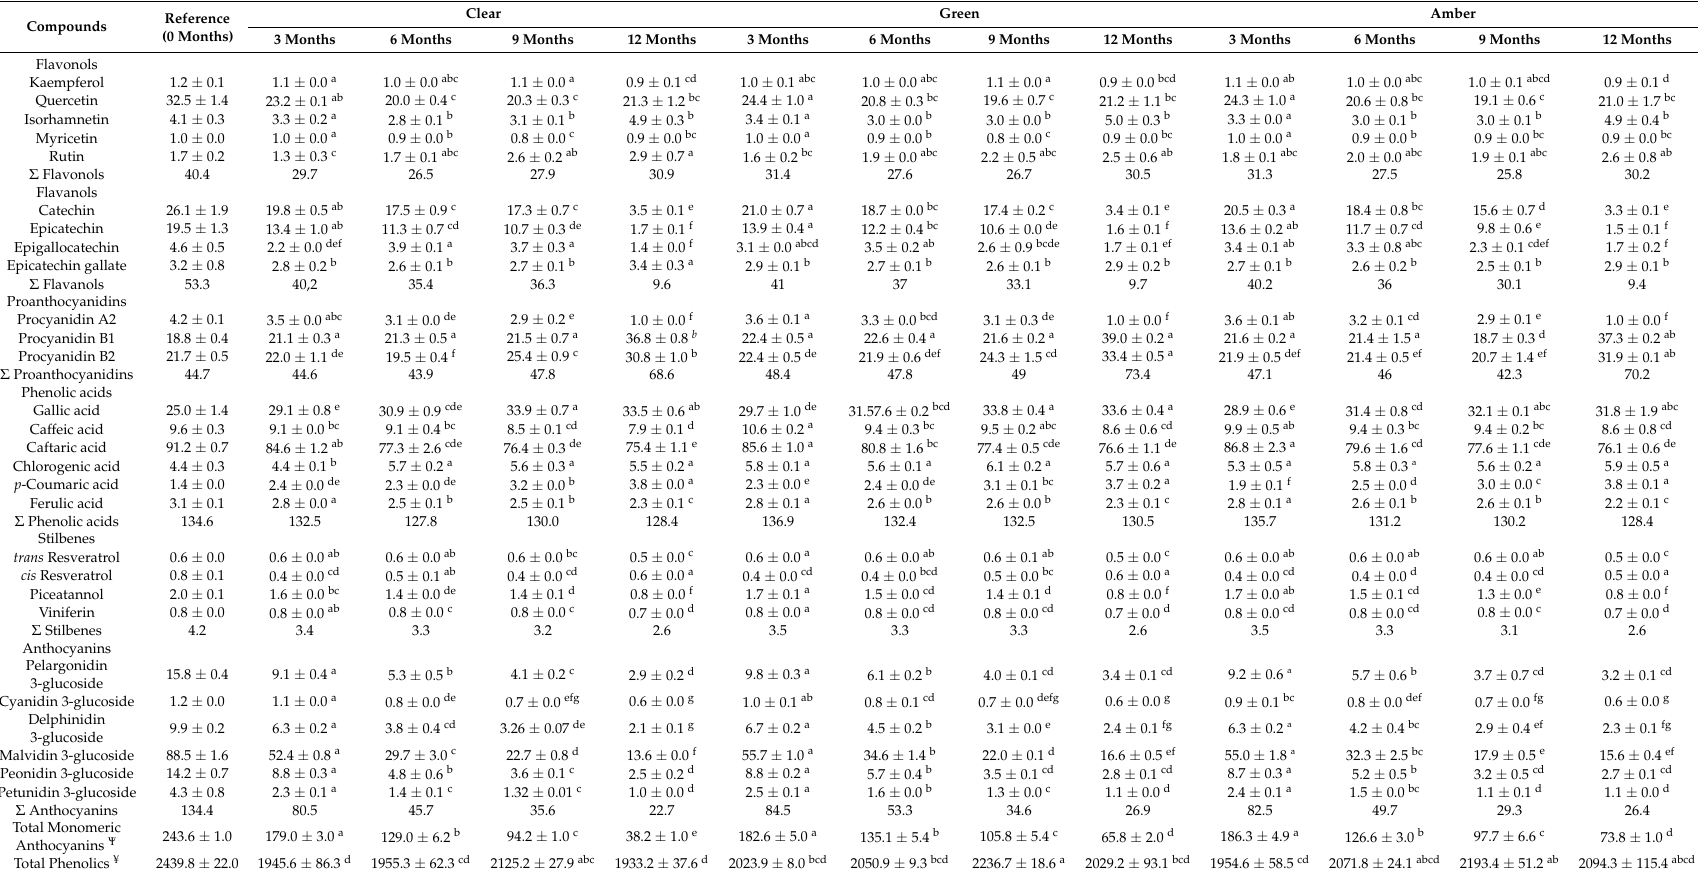
Table 4. Evolution of phenolic compounds (mg L − 1 ) (mean ± standard deviation) in the Syrah red wine stored in bottles of different colors for 12 months. Compounds Reference (0Months) Flavonols Kaempferol